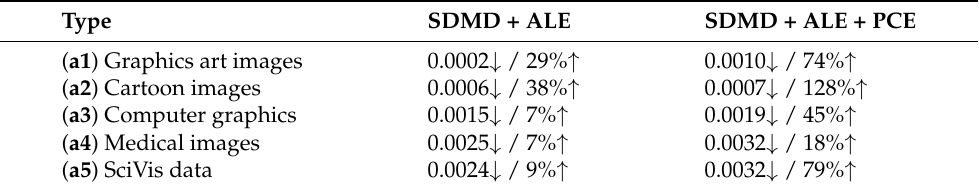
Table 2. Decrease in SSIM ( ↓ ) and increase in CR ( ↑ ) for the adaptive layer encoding (ALE) and ALE plus the per-channel encoding (PCE) as compared to the original SDMD method, averaged per image